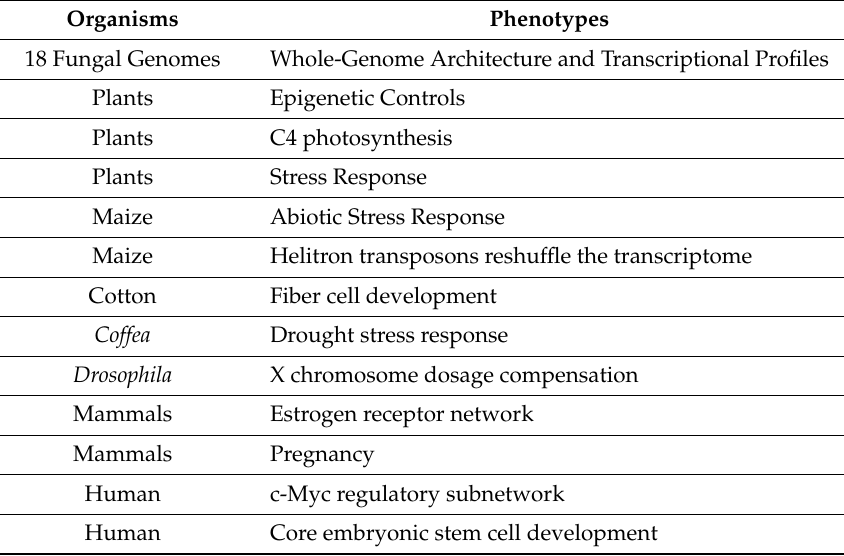
Table 13. Distributed genome network innovation attributed to mobile DNA